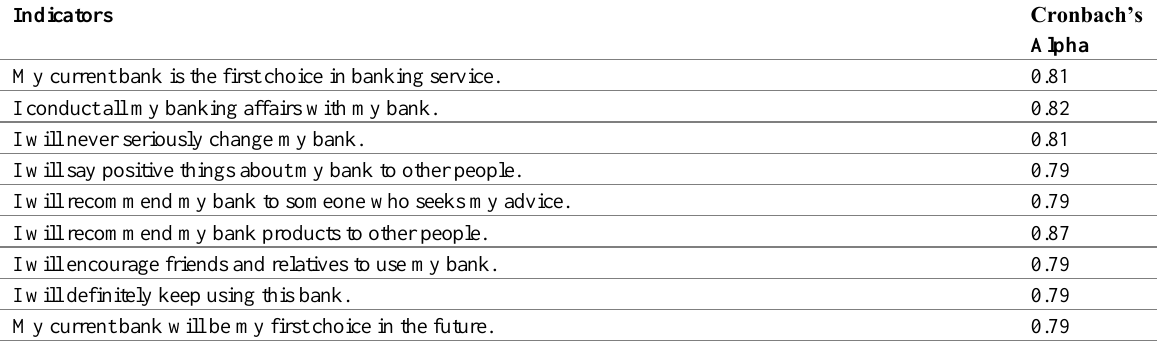
Table 2: All (9) item Cronbach’s alpha reliability score: Customer Loyalty Indicators